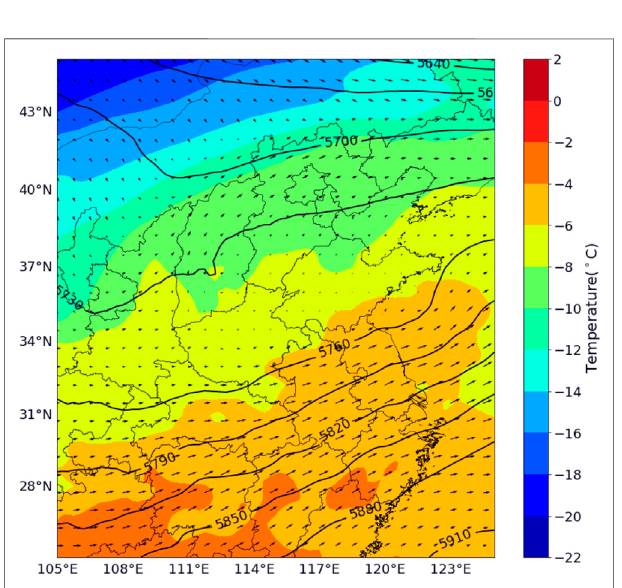
FIGURE 3 | Geopotential height (black contour line, units: pm), temperature (shaded, unit: ° C), and wind fi eld (arrows) at 500 hPa 12:00 on May 15, 2021.